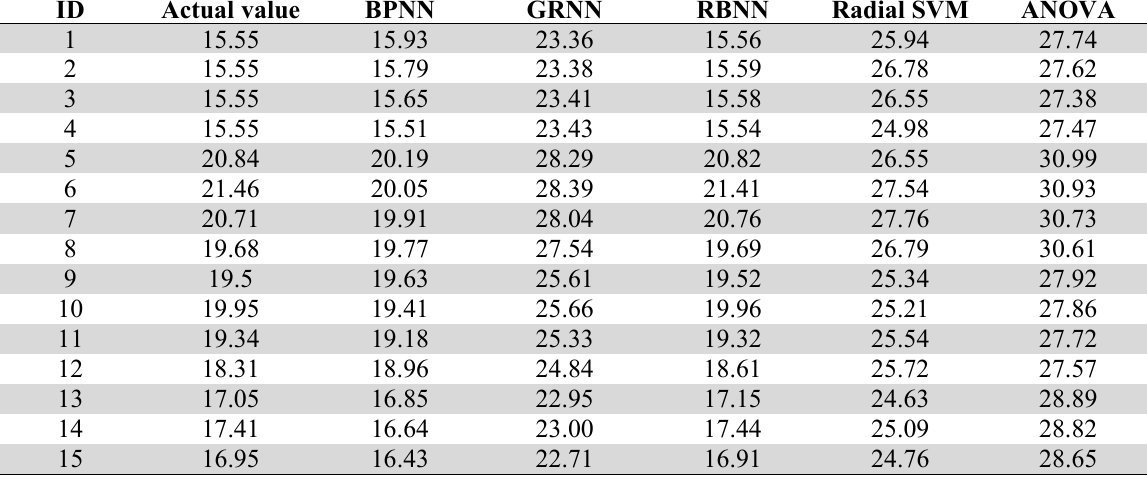
Fig. 2. Actual and predicted heating loads using back-propagation feed forward neural network Predicted heating loads using the five machine learning